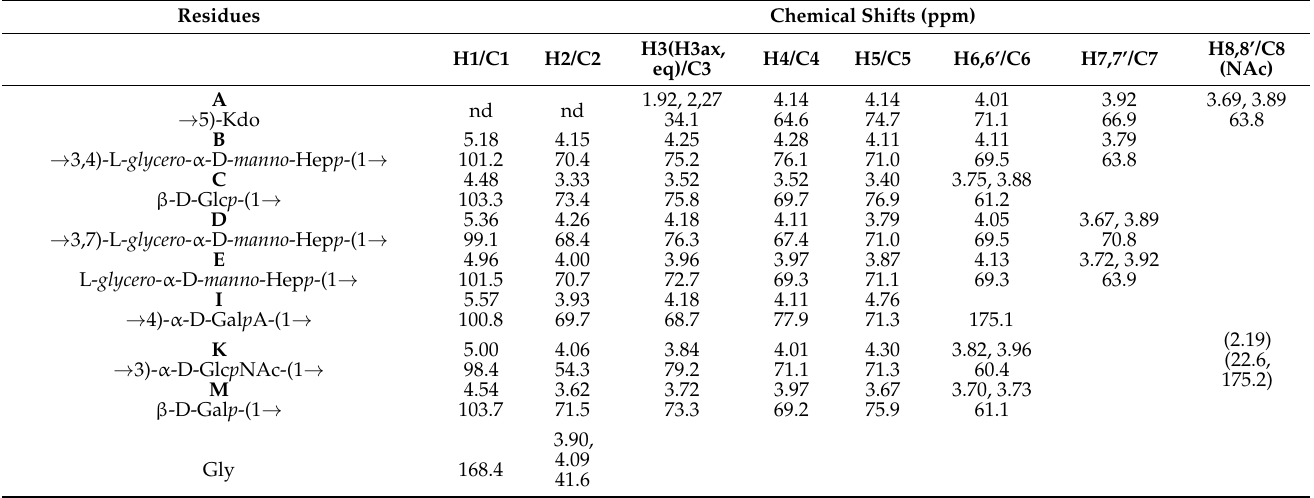
Table 3. Chemical shifts of the E. ictaluri AL-15-01-CATFISH core oligosaccharide